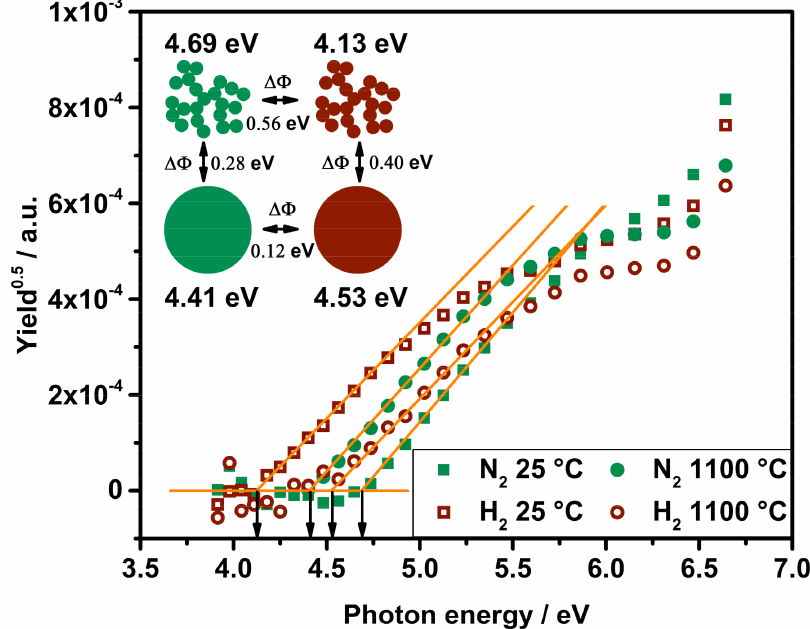
Figure 8. Work function determination of platinum particles in different atmospheres and with different